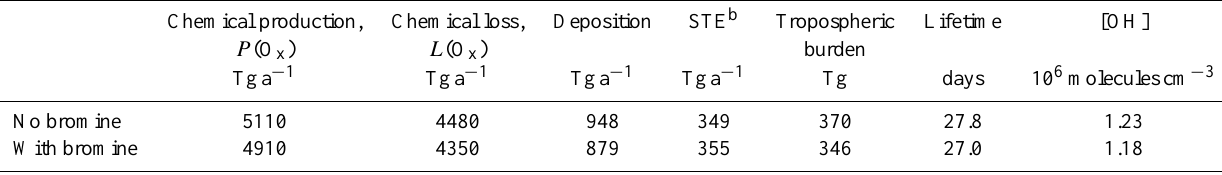
Table 3. Global tropospheric ozone (O x ) budget in GEOS-Chem a . Chemical production, Chemical loss, Deposition STE b Tropospheric Lifetime